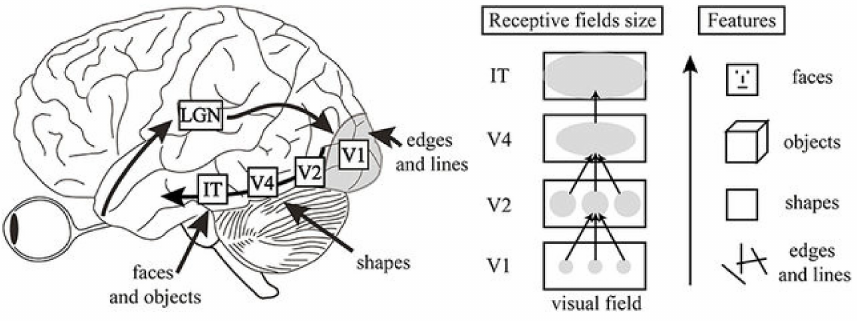
Figure 4. Visual information processing structure model in brain